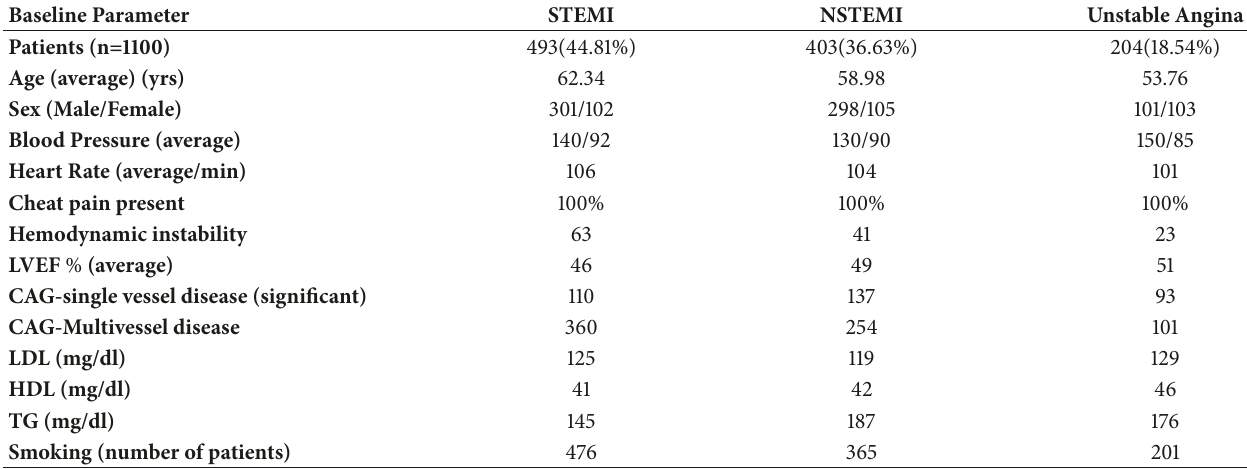
Table 1: Showing results of baseline demographics in all 3